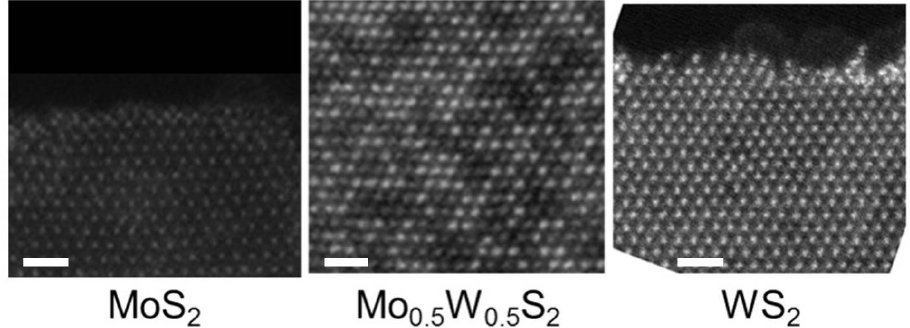
Figure 1. HAADF-STEM micrographs of MoS 2 ( left ), Mo 0.5 W 0.5 S 2 ( center ) and WS 2 ( right ) samples. The difference in contrast between the Mo and S atoms can be seen in the micrograph corresponding to Mo 0.5 W 0.5 S 2 in the form of brighter and dimmer spots. This is the difference in contrast that has been used to estimate the alloying degree as stated in the literature [71]. Scale bar: 1 nm.